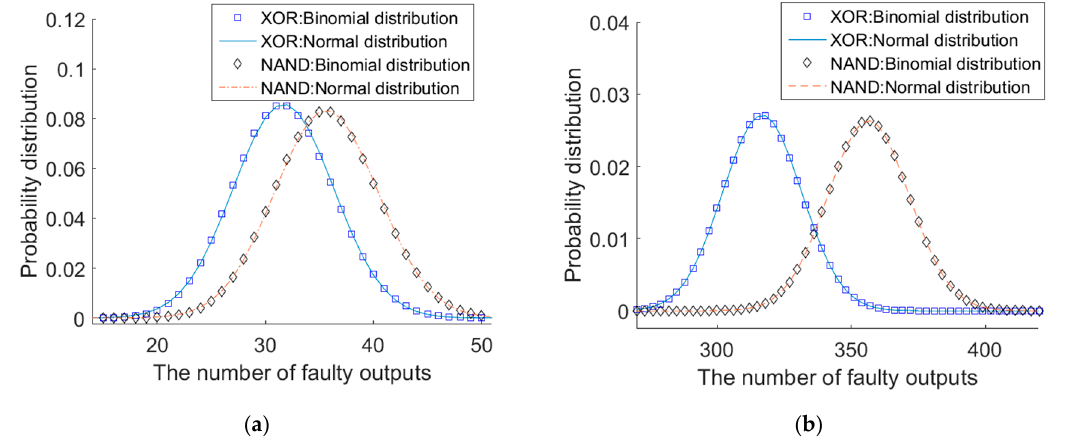
Figure 2. The error distributions of the XOR multiplexing unit and the NAND multiplexing unit: ( a ) N = 100; ( b ) N = 1000.